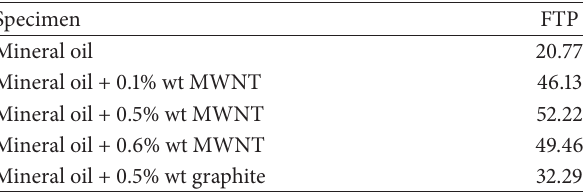
Figure 5: FTP values of different oil samples. Table 4: FTP values of all the specimens.